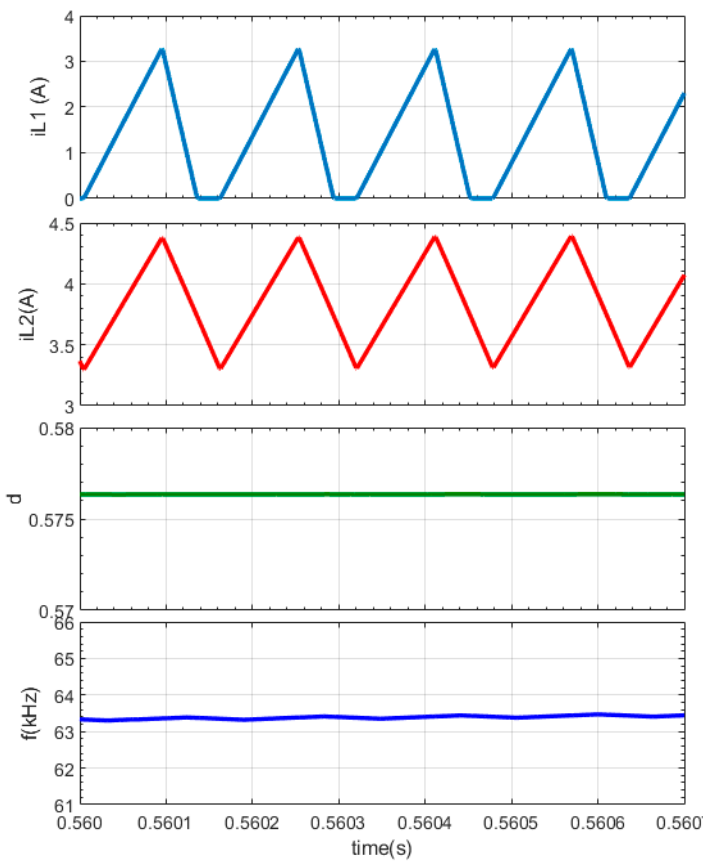
Figure 9. Simulation results for the conversion circuit based on two switches S 1 and S 2 (Figure 5, top). From top to bottom: i L 1 , i L 2 , D and f .